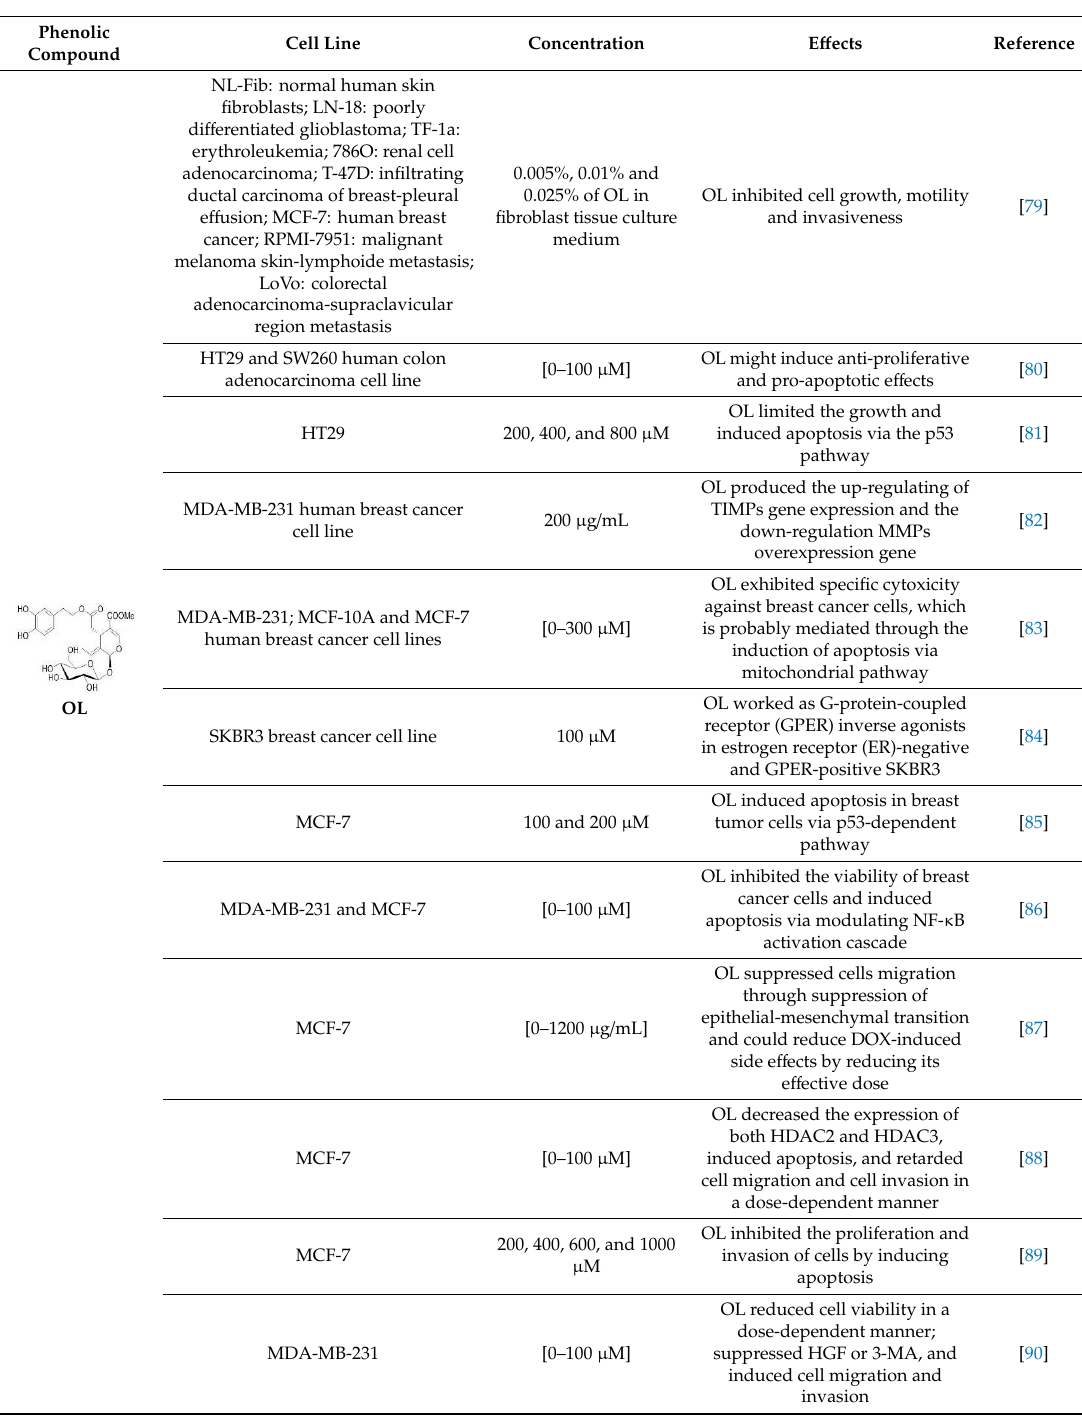
tree in the control and progression of di ff erent types of